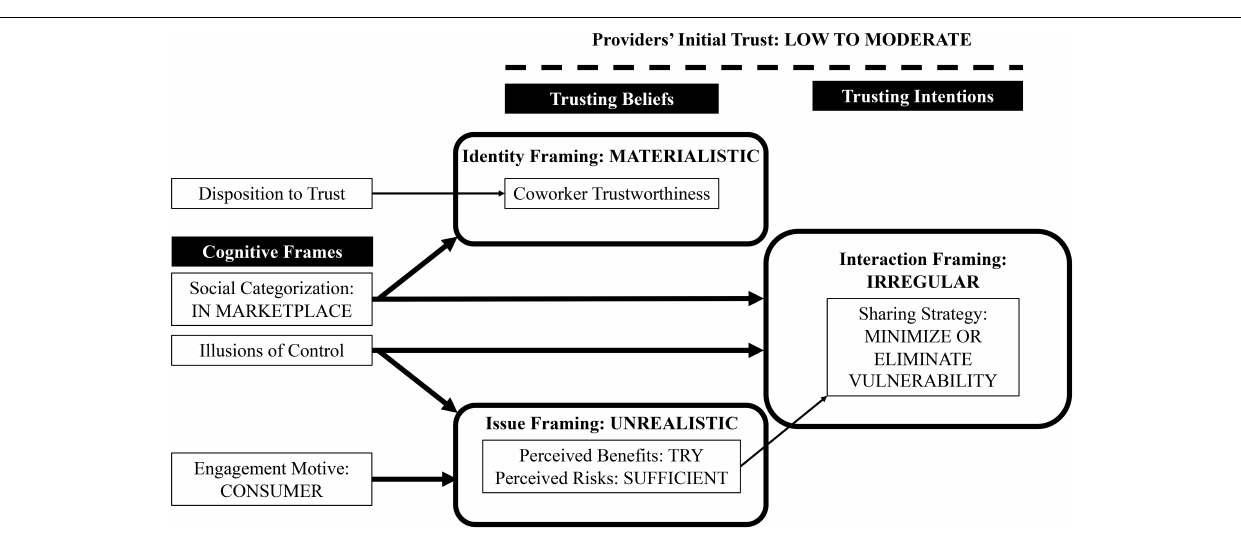
FIGURE 4 | Providers’ initial trust when coworker collaborative consumption is framed as sharing within a marketplace of